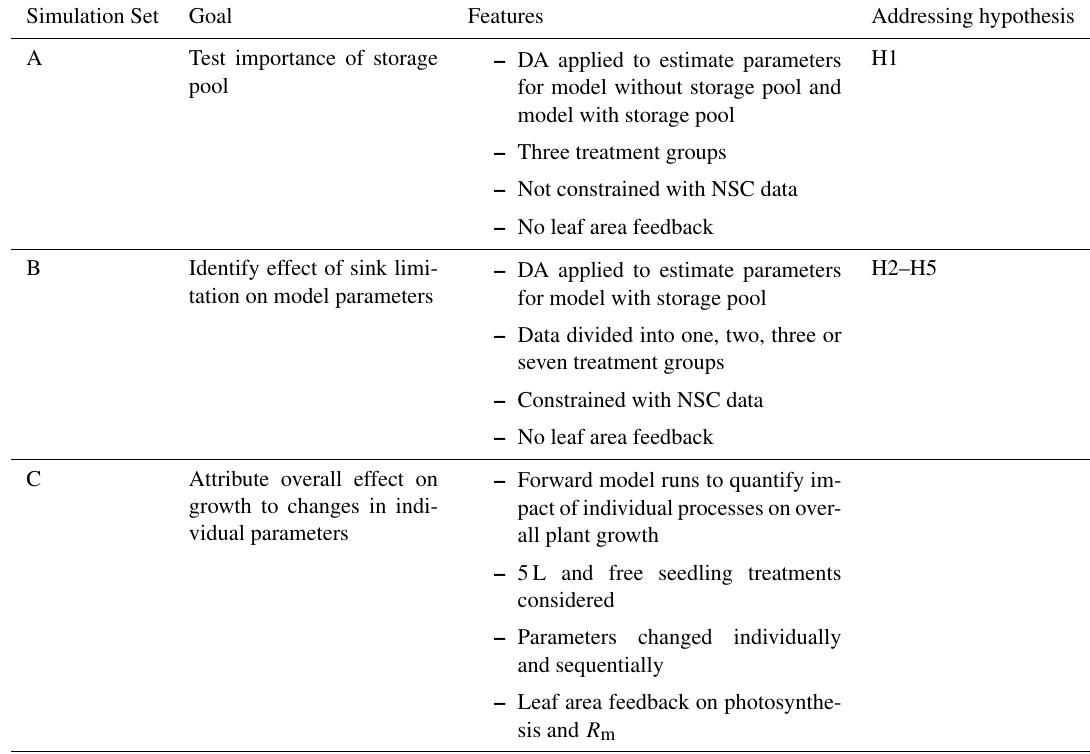
Table 1. Summary of the three model simulation